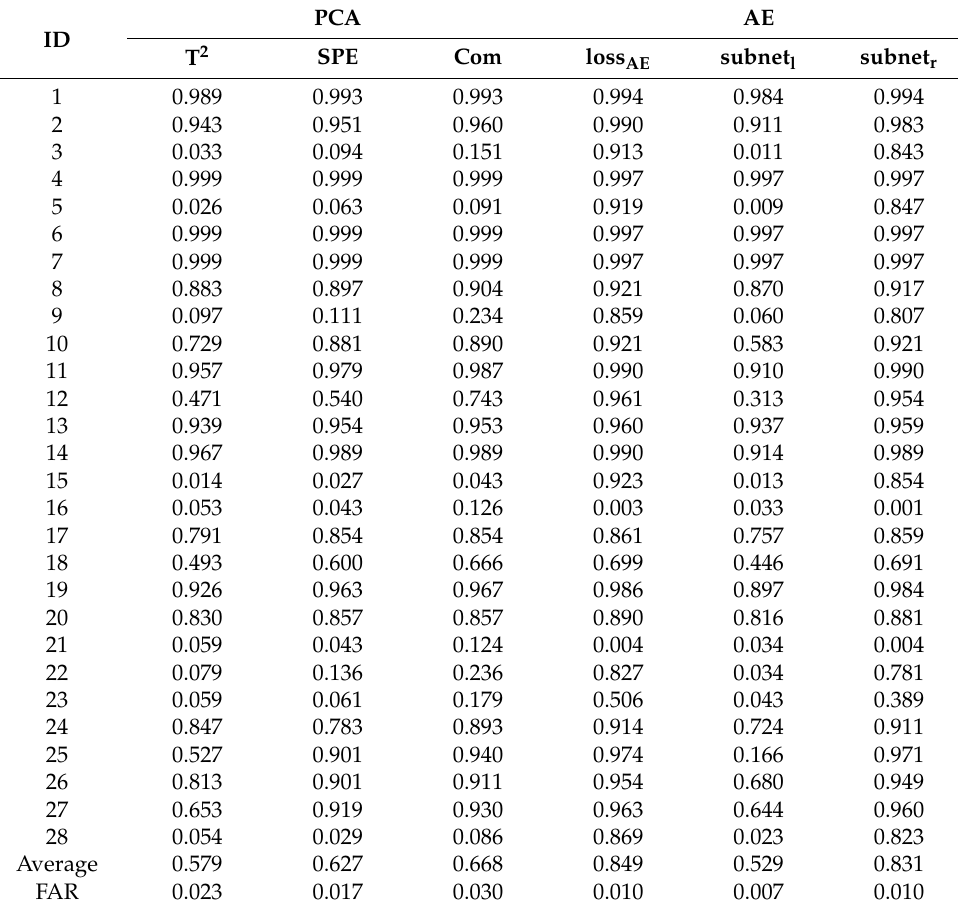
Table 2. Fault detection by PCA and